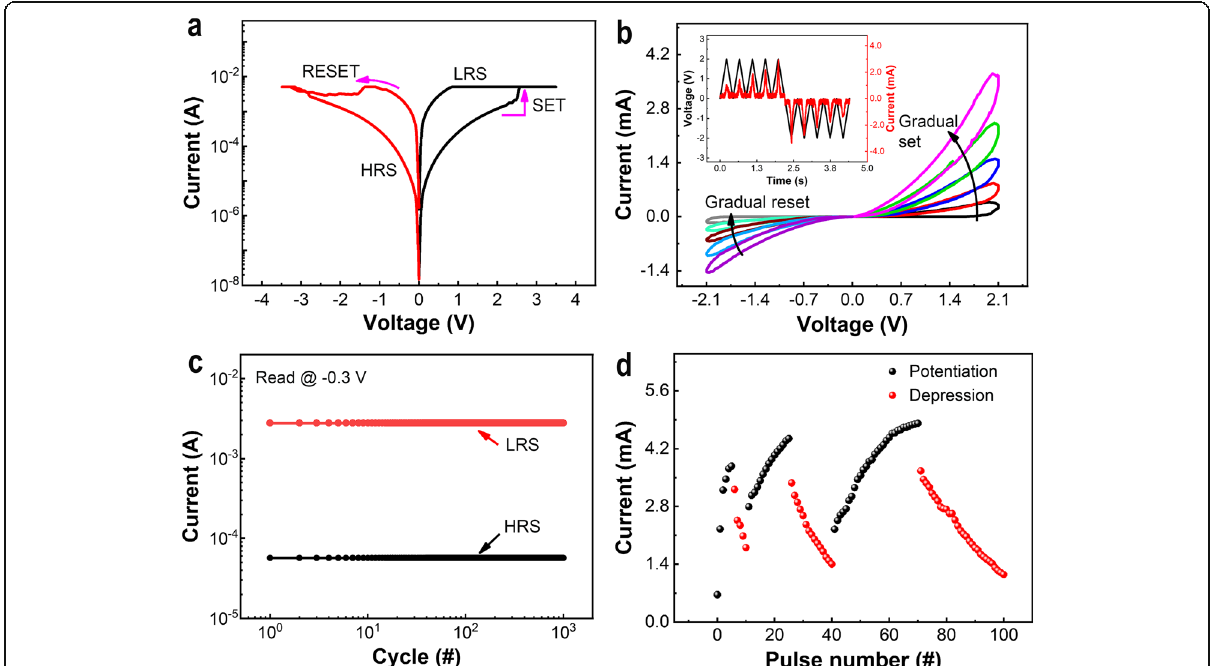
Fig. 2 I – V characteristics of the Ag/SiO x :Ag/TiO x /p ++ -Si memristor device. a Bipolar switching behavior b Potentiation or depression by repeating voltage sweeps. The inset shows the voltage and current versus time relation (V-I-t), demonstrating the conductance state during potentiation or depression. c Endurance-cycling performance test at a readout voltage of -0.3 V for 10 3 cycles of a broader range of bipolar sweeps from 0 to +4.0 V for set and 0 to − 4.0 V for reset. d Repeated properties of conductance